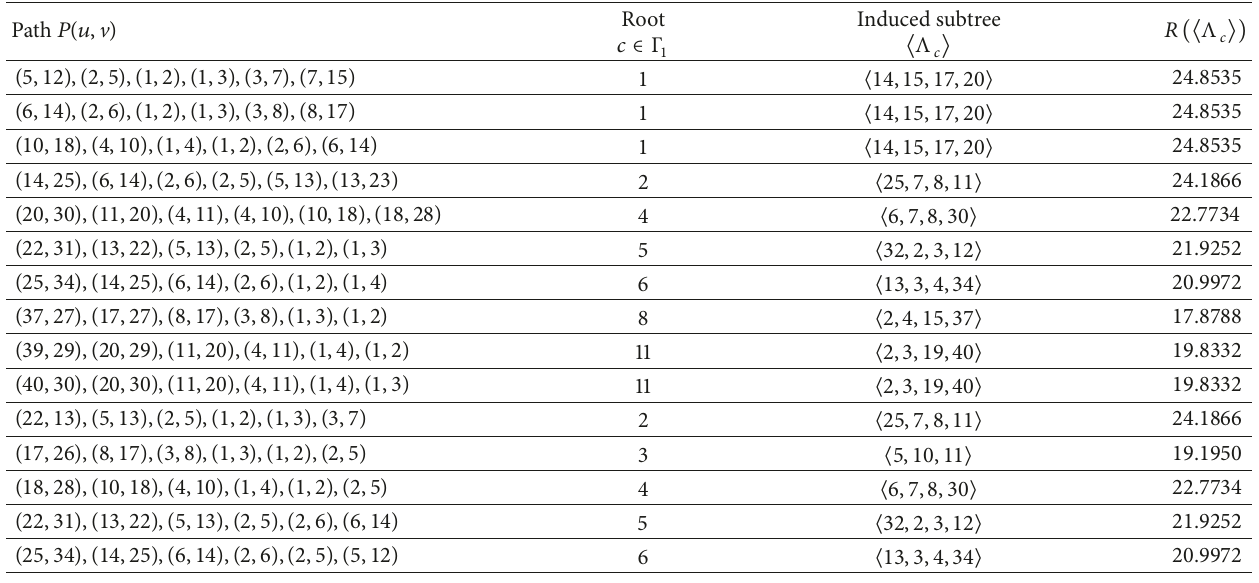
Table 3: Some paths of length 7, their centers, the induced subtrees with maximum reliability saving, and the reliability sum of each subtree. Path 𝑃(𝑢, V ) (3,7), (1,3), (1,2),(2, 6),(6, 14),(14, 25), (25,34) (2,6)